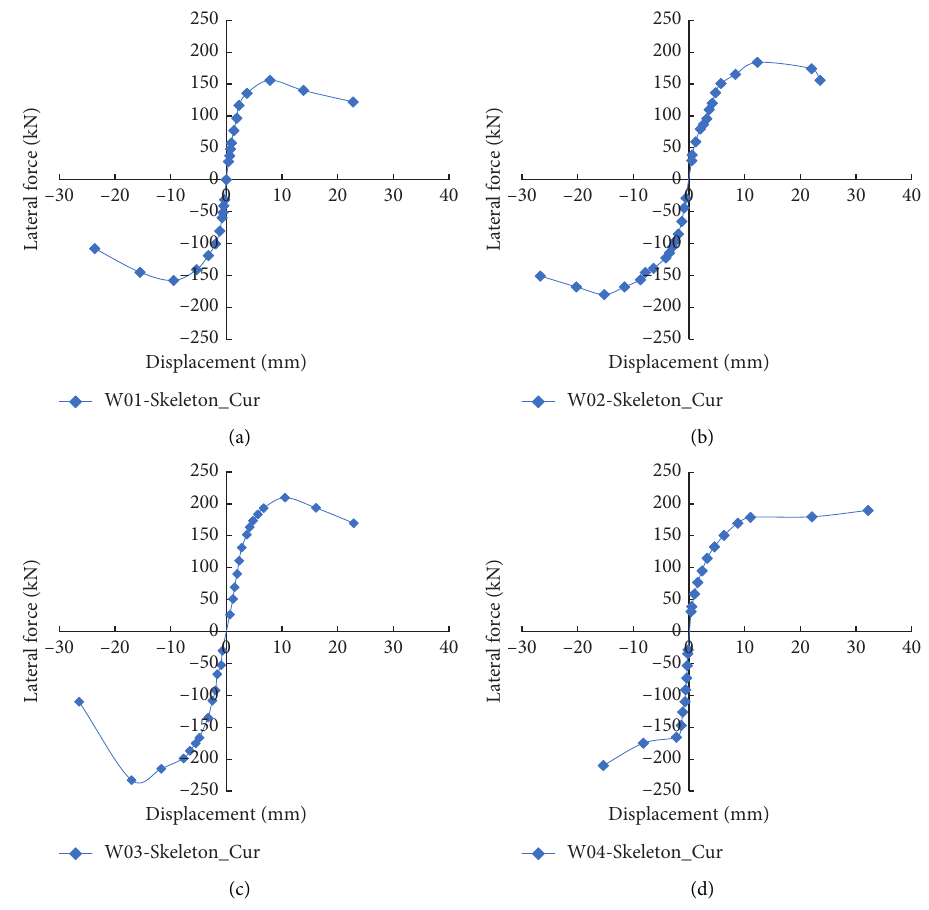
Figure 7: Skeleton curve of the test specimen. (a) W01. (b) W02. (c) W03. (d)